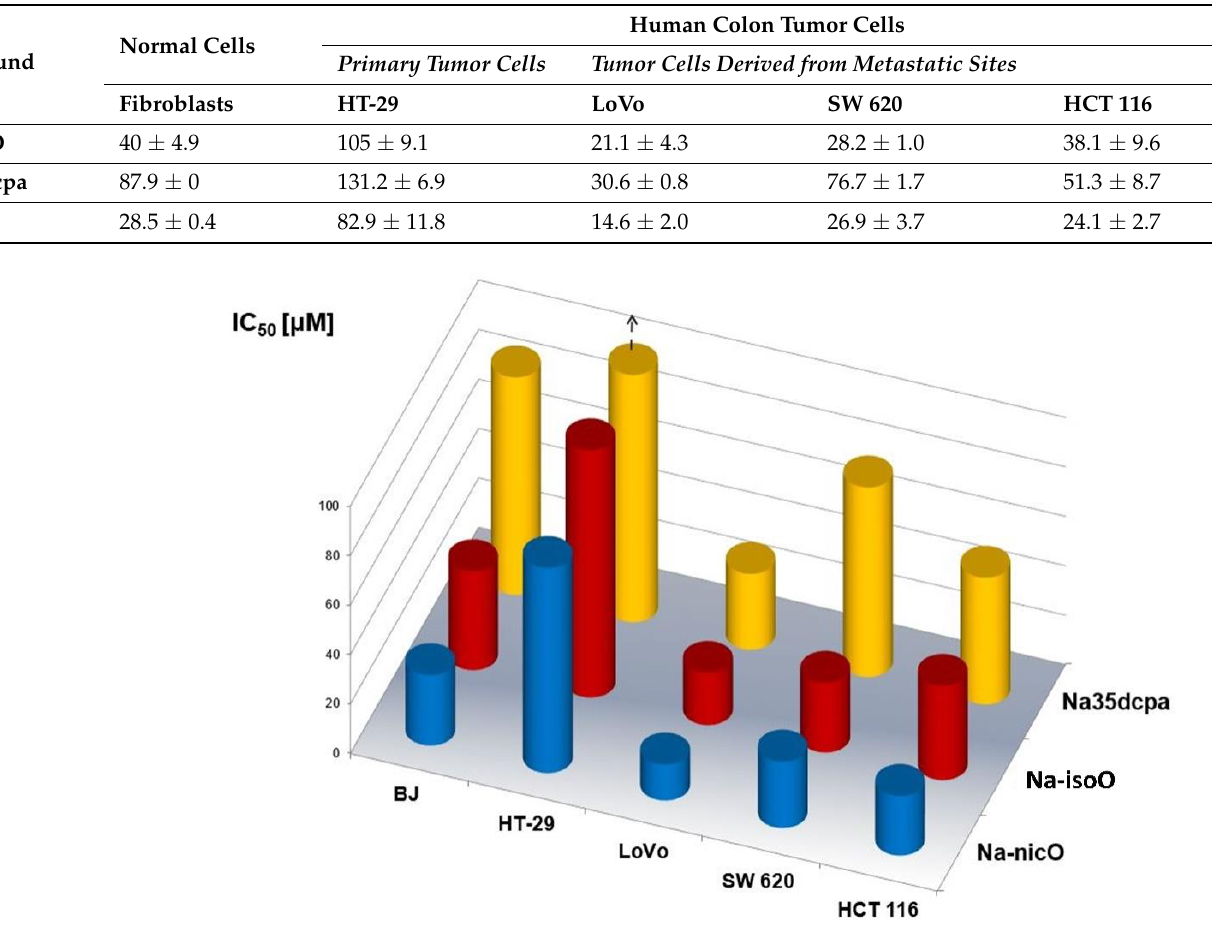
Figure 7. Scheme of the catalytics of the BV cyclohexanone oxidation with molecular oxygen and peroxidomolybdates as catalysts [31].